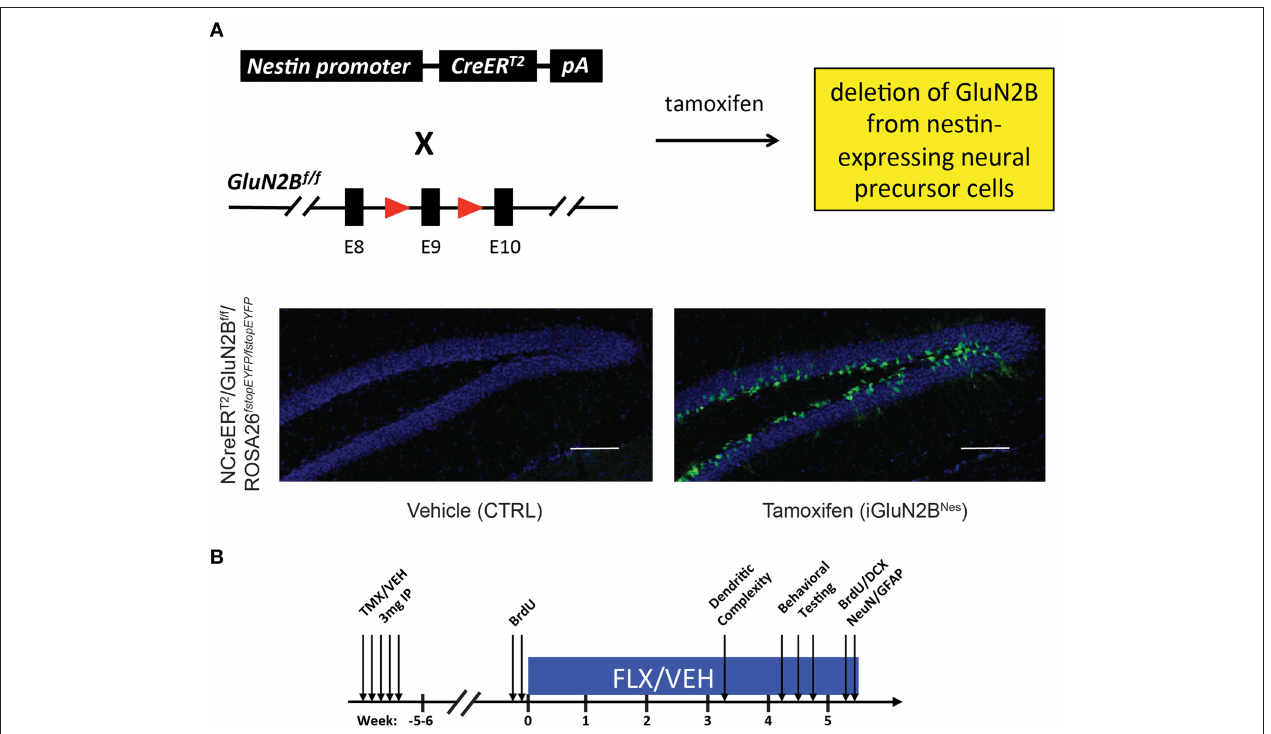
FIGURE 1 | Experimental Design. (A) Genetic design for the deletion of GluN2B from abGCs. TMX administration into NCreER T2 × GluN2B f / f × ROSA26 fstopEYFP / fstopEYFP mice eliminates the GluN2B subunit from NPCs and all of their progeny, while EYFP labels cells that underwent recombination thus acting as a surrogate for GluN2B deletion. Representative 10X images show cells are restricted to the lower portion of the granule cell layer near the subgranular zone, consistent with the expression pattern of immature abGCs (scale bar = 100 µ m). (B) Experimental timeline: Adult NCreER T2 × GluN2B f / f × ROSA26 fstopEYFP / fstopEYFP mice were injected with either TMX (iGluN2B Nes ) or vehicle (CTRL). FLX or VEH treatment began 6 weeks later. Behavioral testing began after 4 weeks of chronic AD treatment. For dendritic complexity analysis, FLX or VEH treatment began 5 weeks after induction and mice were sacrificed after 3 weeks of AD